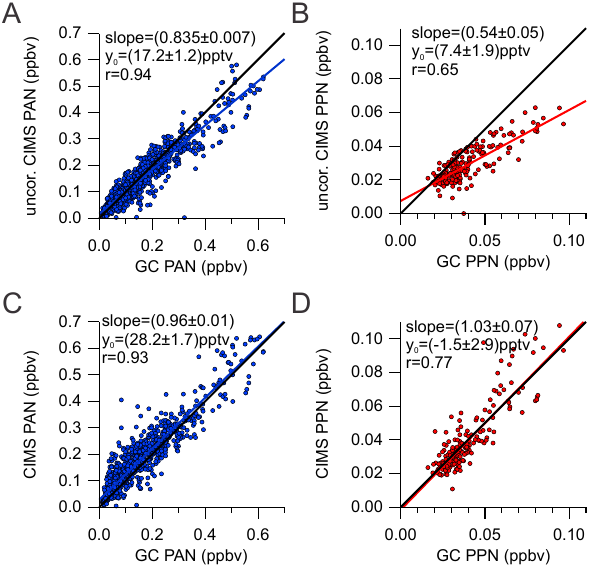
Figure 11. Scatter plots of TD-CIMS and PAN-GC data. (a) PAN, uncorrected. (b) PPN, uncorrected. (c) PAN, corrected. (d) PPN, corrected.